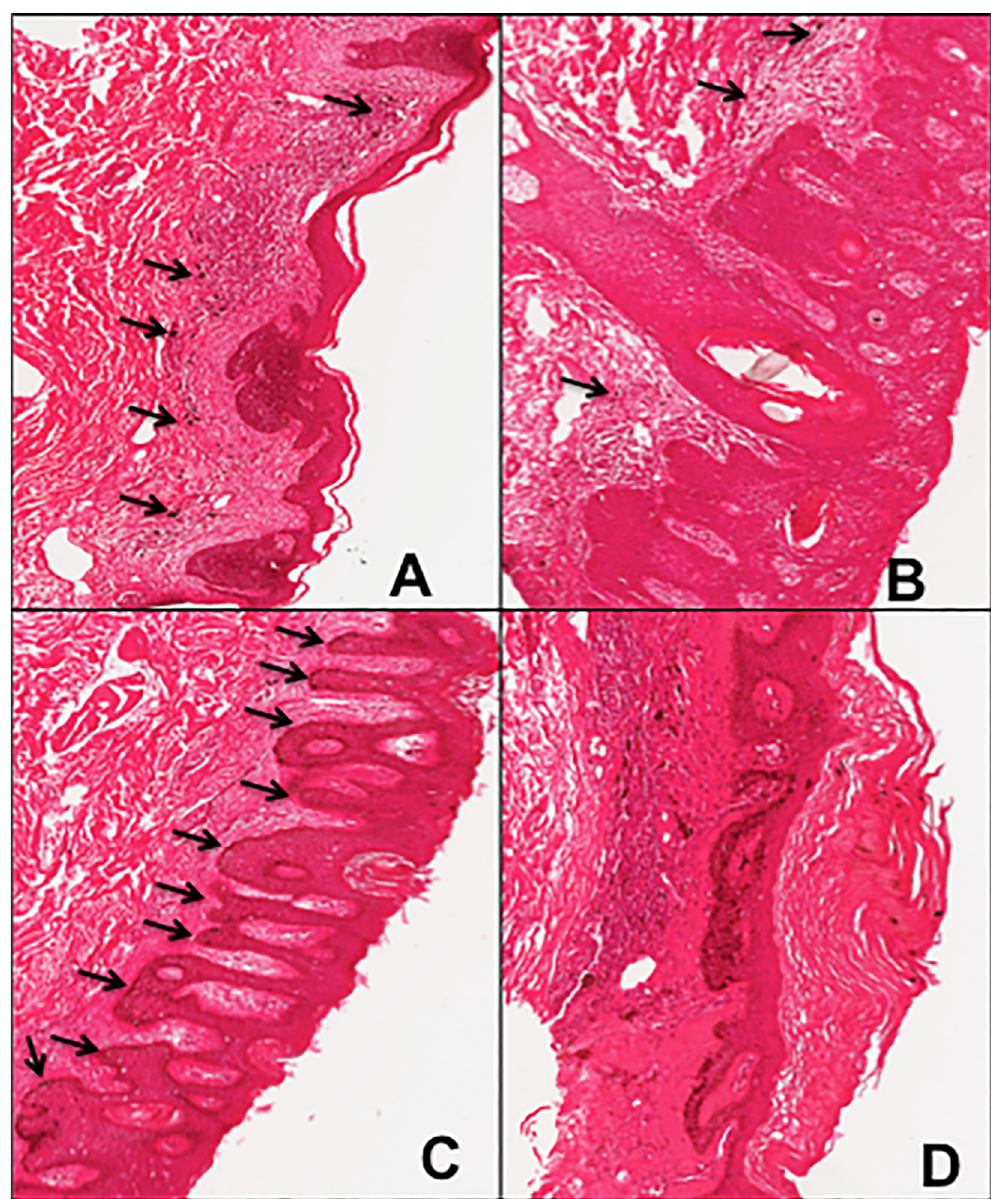
Fig 2. Arsenic induced premalignant and malignant skin lesions. Histological sections of arsenic-induced basal cell carcinoma, squamous cell carcinoma and hyperkeratosis. A. Basal cell carcinoma, arrows point to inflammatory foci. B. Squamous cell carcinoma, arrows point to inflammatory foci. C. Hyperkeratosis with dysplasia, arrows point to areas of dysplasia projecting from the hyperkeratotic region. D. Hyperkeratosis without dysplasia.